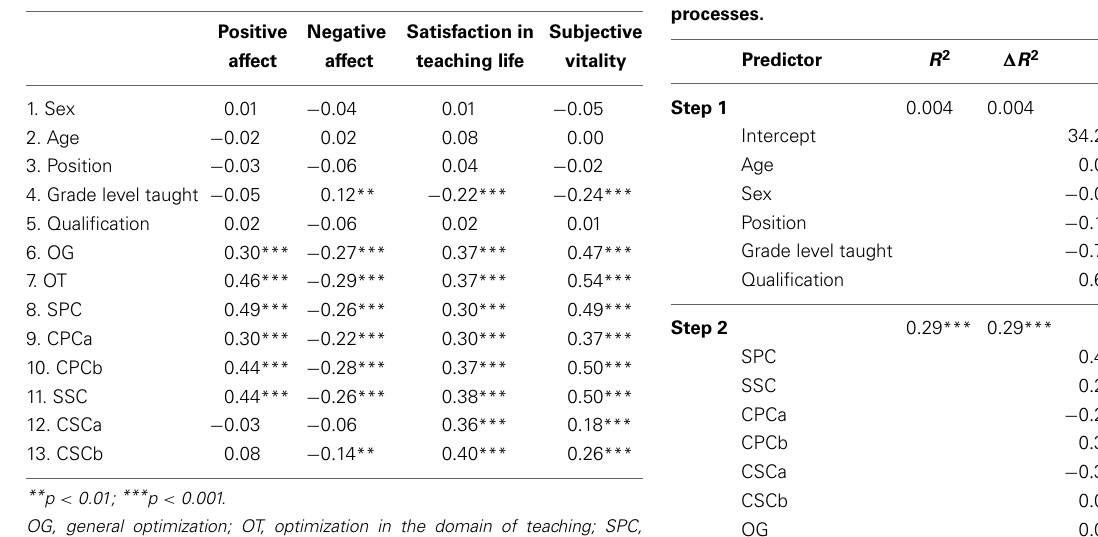
Table 4 | Summary of hierarchical multiple regression